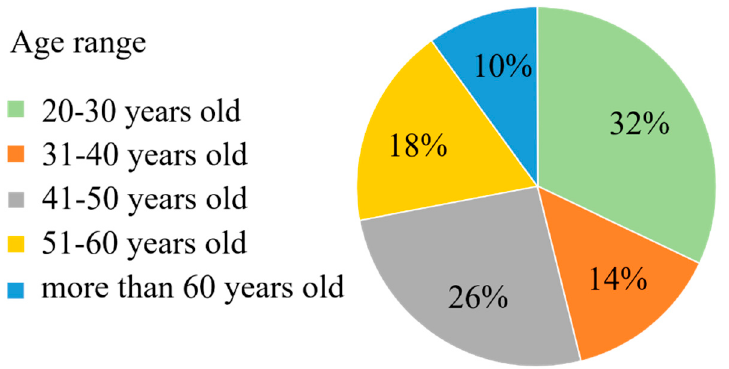
Figure 1. Age range of interviewed consumers.